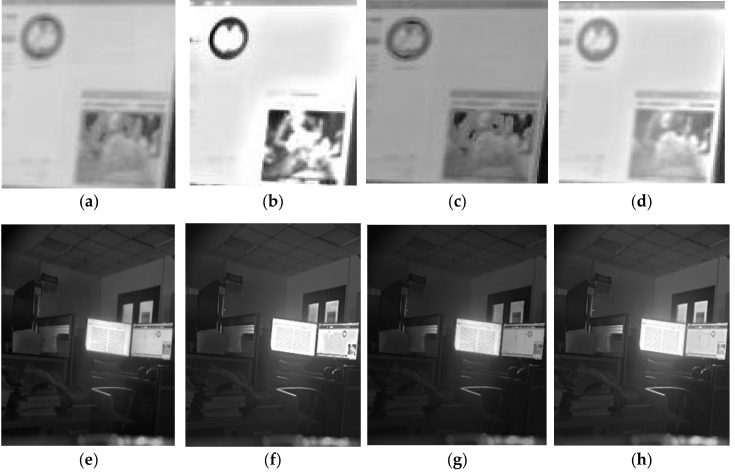
Figure 10. Comparison of different methods of indoor images. ( a ) The local image of [16]. ( b ) The local image of [29]. ( c ) The local image of [15]. ( d ) The local image of our method. ( e ) The fusion image of [16]. ( f ) The fusion image of [29]. ( g ) The fusion image of [15]. ( h ) The fusion image of our method.